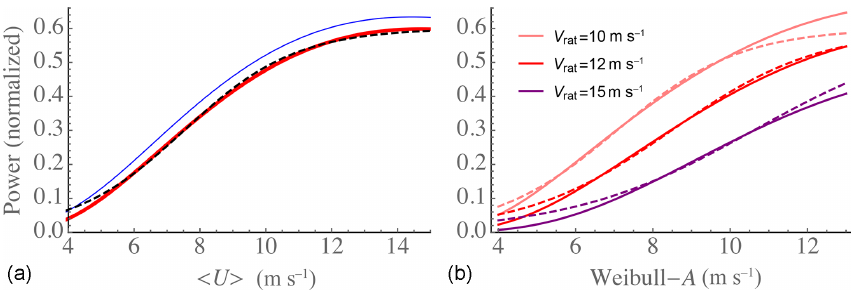
Figure A3. (a) Normalized power vs. mean wind speed for k = 2, V rat = 12ms − 1 ; blue is for ideal truncated (sharp) power curve, red is via numerically integrated universal power-curve form (Eq. B1), black dashed is approximation (Eq. B3) to universal form, and (green) dotted is for simple U 3 form. (b) Normalized power (convolution of Eq. B1 and Weibull distribution) as a function of Weibull- A parameter for rated speeds of 10ms − 1 (pink), 12ms − 1 (red), and 15ms − 1 (purple); dashed lines indicate analytic approximation as in Eq. (B3).